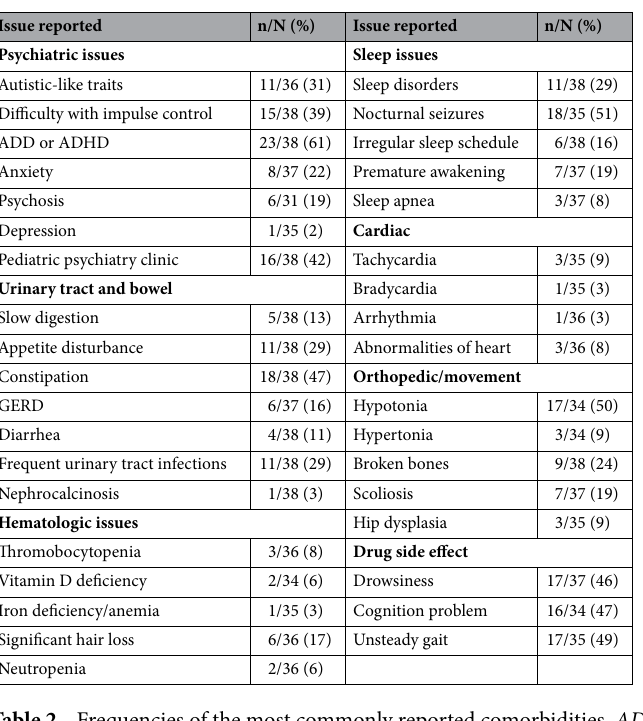
Table 2. Frequencies of the most commonly reported comorbidities. ADD attention-deficit disorder, ADHD attention-deficit hyperactivity disorder, GERD gastroesophageal reflux disease.